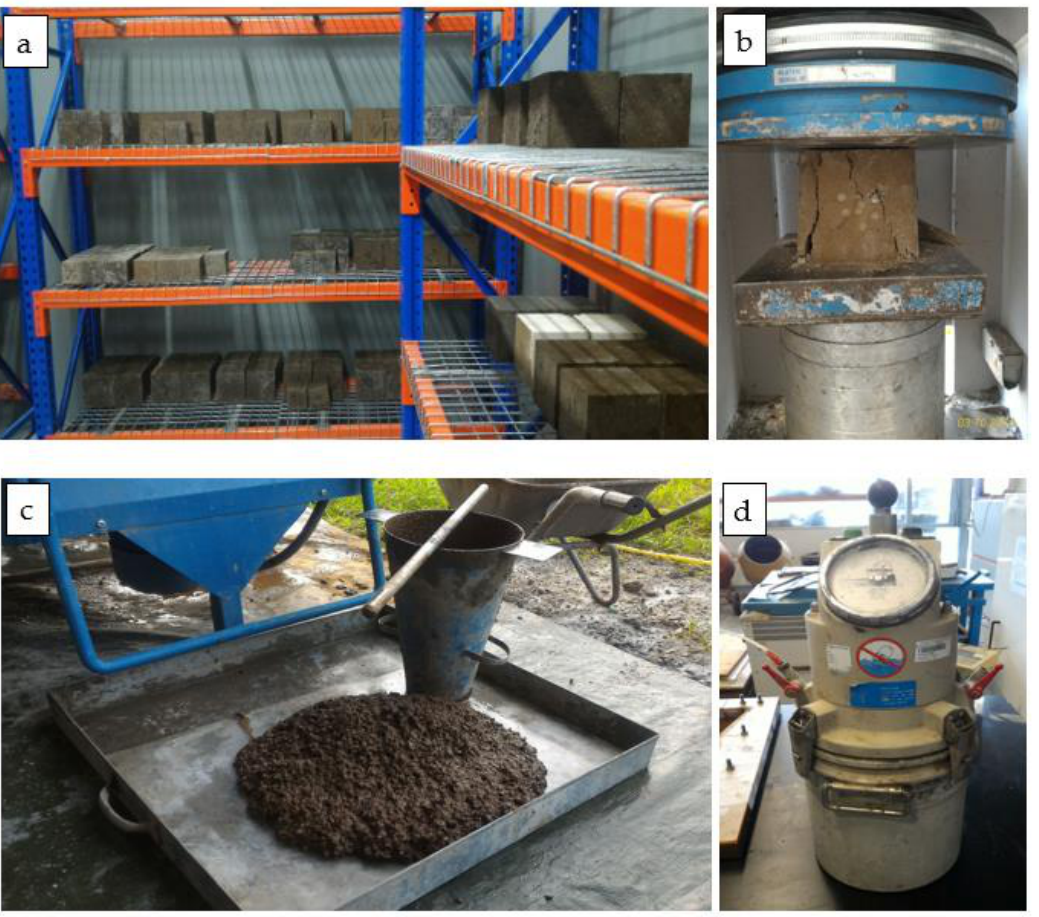
Figure 1. ( a ) Concrete specimens, ( b ) loading machine, ( c ) slump test, and ( d ) air content apparatus, respectively.